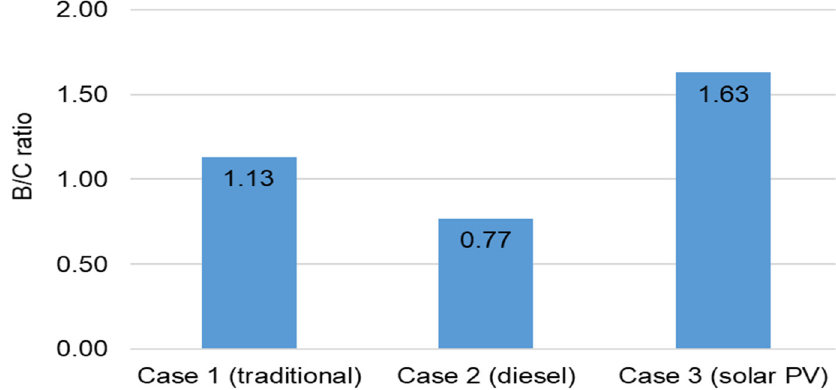
Figure 6. B/C ratio for a reference farmer in a year (from 0.15 ha land).